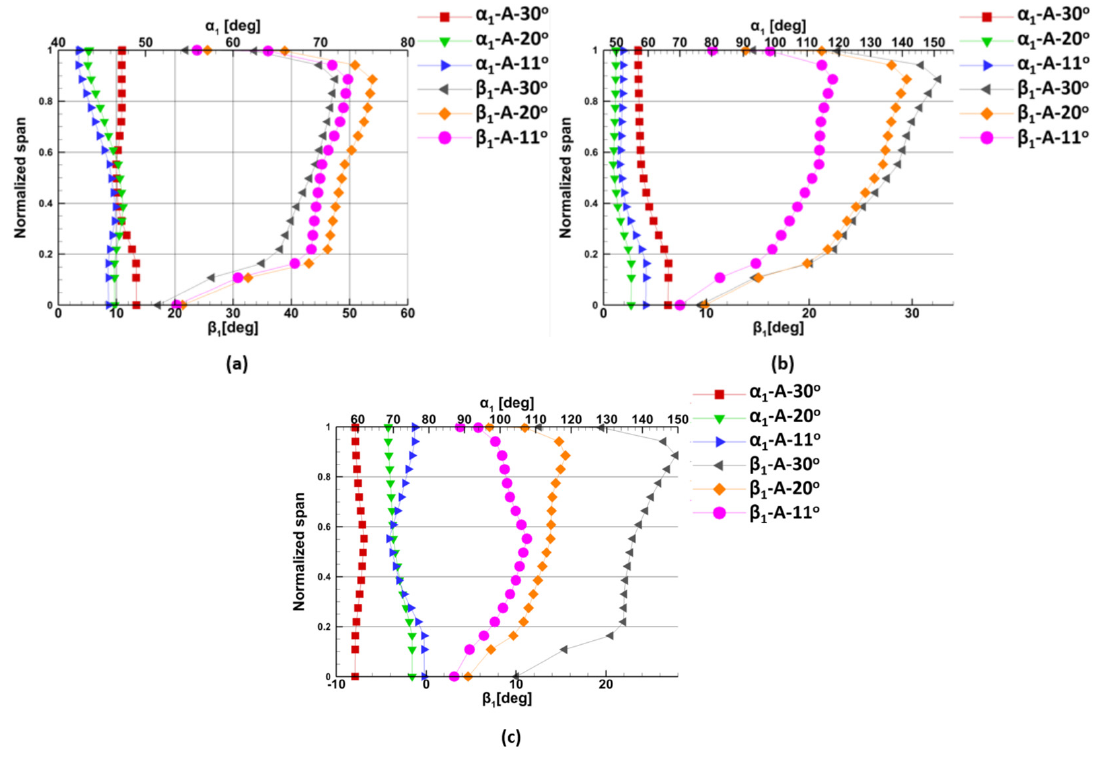
Figure 30. The plots of the absolute ( α 1 ) and relative ( β 1 ) angles measured behind the 1st stage nozzle vane against the blade height at 60,000 rpm for: ( a ) point A, ( b ) point B, ( c ) point